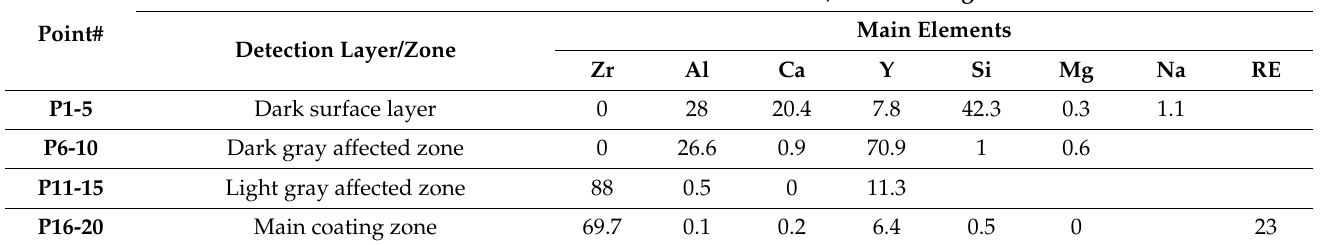
Table 2. Results of SEM/EDXS analyses in the tri-phase (t’+c+YAG) TBC after the CMAS corrosion test at 1250 ◦ C for 120 h.